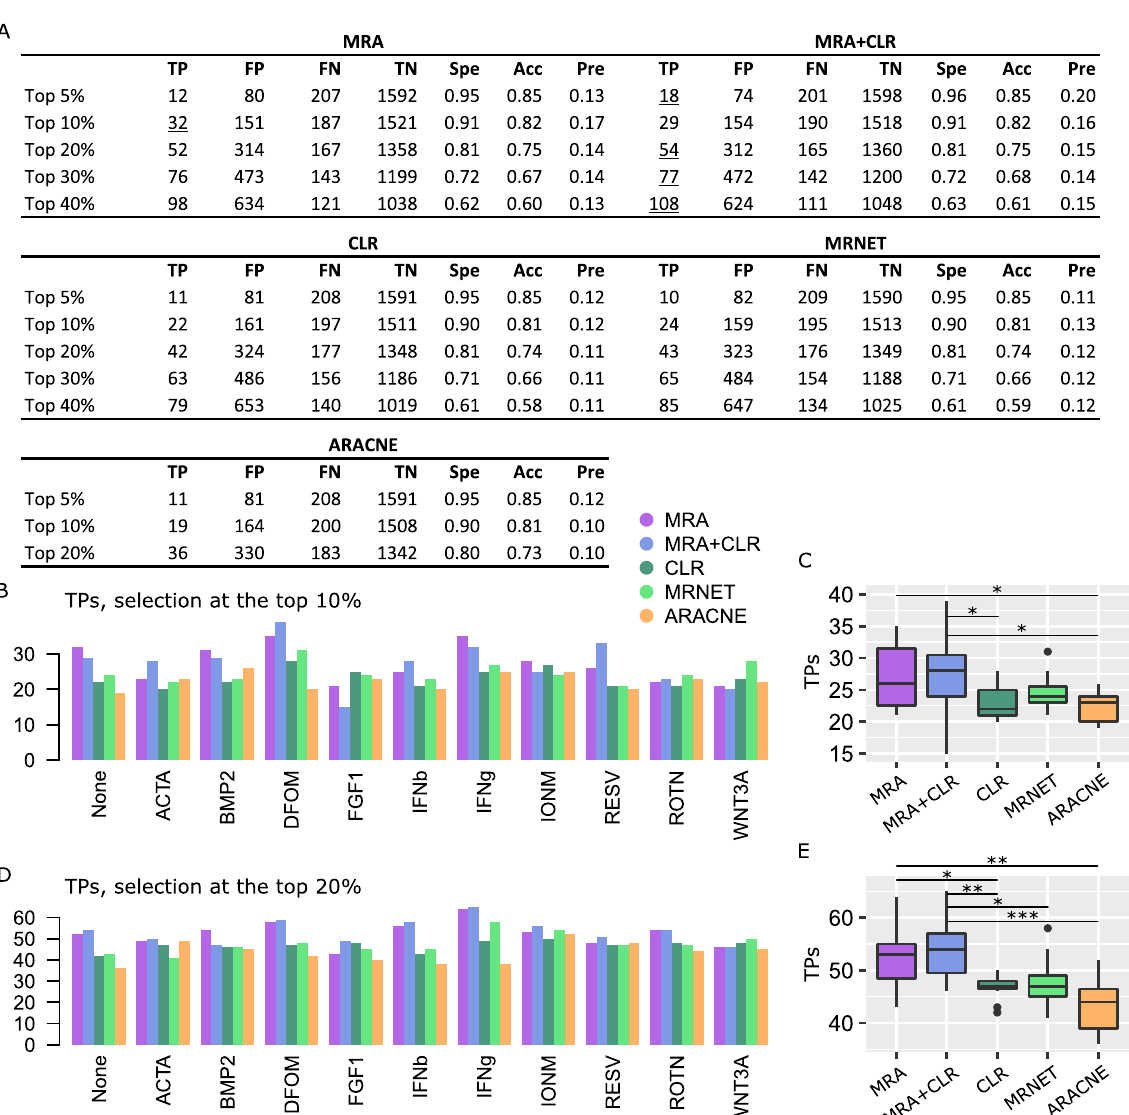
Fig 2. Performance on K61 data against STRING interactions (STRING score > 0.5). (A) Representative confusion matrices for the None condition. Spe = specificity, Acc = accuracy, and Pre = precision. Underlined values represent maxima. Note that in some cases, ARACNE did not return enough interactions to perform a number of selections equal to the top 30% or 40% of all possible interactions. We ignored those cases, hence the missing numbers. (B) TP numbers at the top 10% selection level. (C) Comparison between the algorithm TP numbers (Wilcoxon test, 2-sided, � P < 0.05). (D) TP numbers at the top 20% selection level. (E) Comparison between the algorithm TP numbers (Wilcoxon test, 2-sided, � P < 0.05, �� P < 0.005, ��� P <